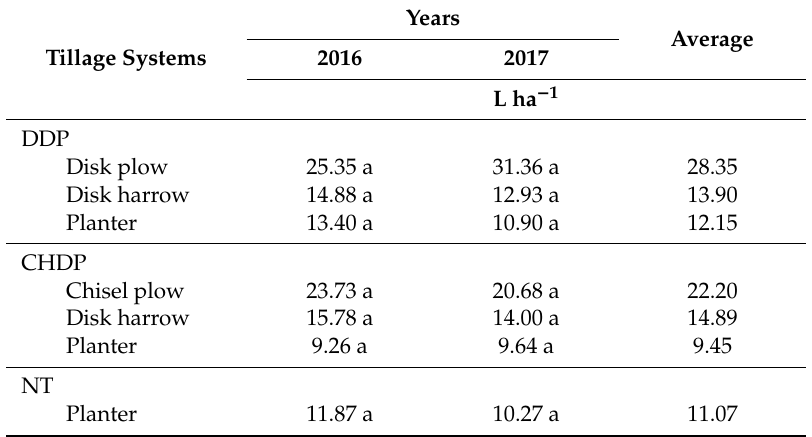
Table 9. Fuel consumption per worked area for each operation in the tillage systems.